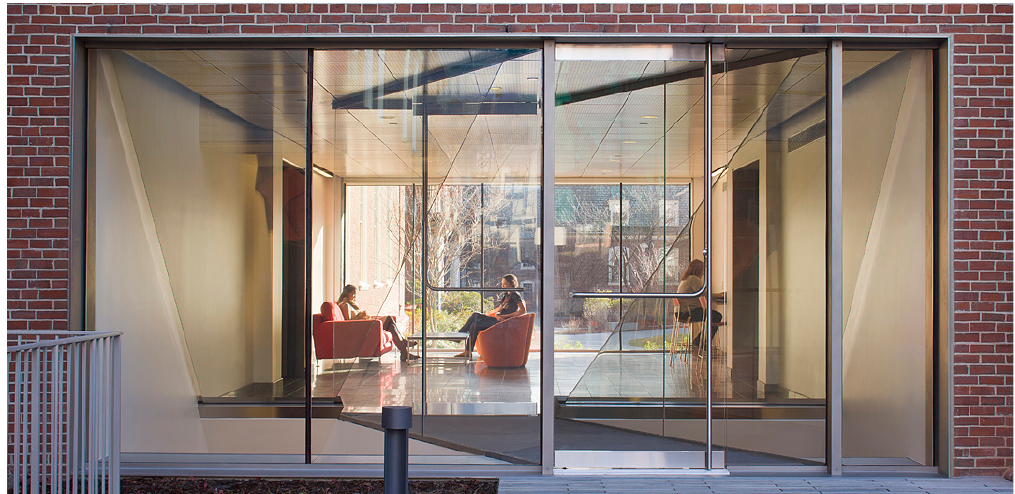
Fig. 1 P-131317, 2011 | Glass and existing architecture | Total dimensions variable Brown University Cognitive Science Building | Providence RI, USA Photo Credit: Warren Jagger | Exterior daytime view